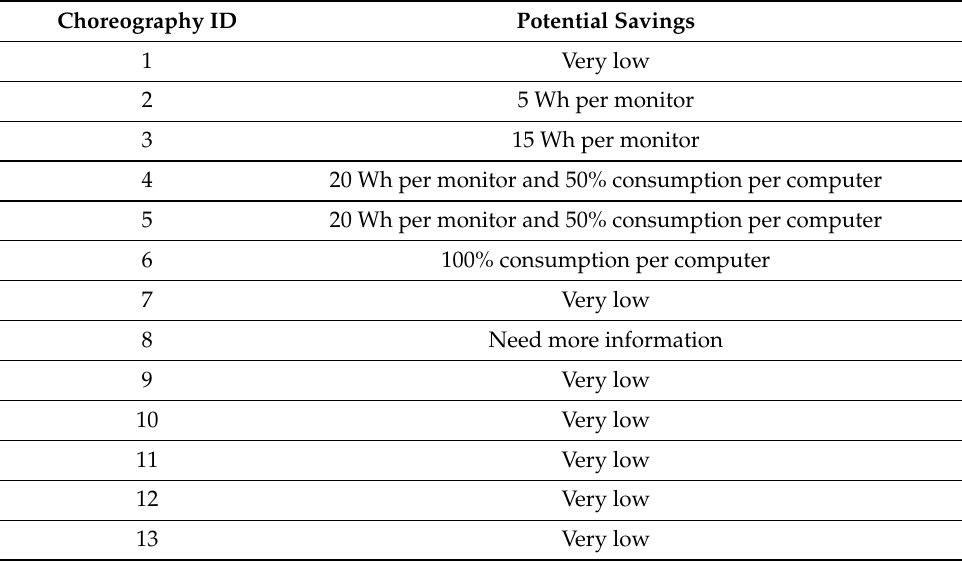
Table 11 resumes the potential savings by choreography that was previously described. Table 11. Potential savings by